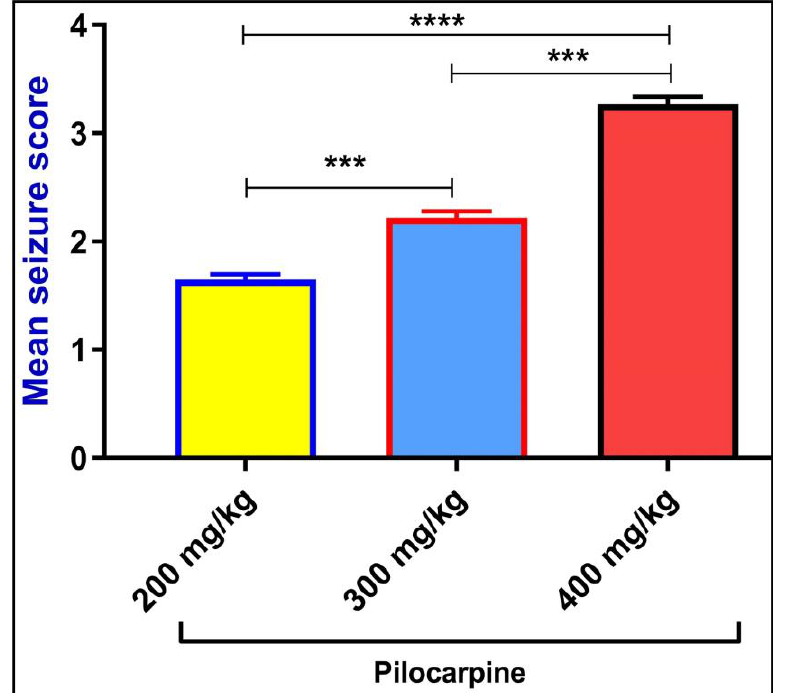
Figure 2. Dose standardization study of pilocarpine in adult zebrafish. All the values were expressed as mean ± SEM and each data point was the average of 8 fish in each group ( n = 8). Statistical analysis was carried out using ANOVA. P < 0.05 was considered significant * p < 0.05, ** p < 0.01, *** p < 0.001 and **** p < 0.0001.